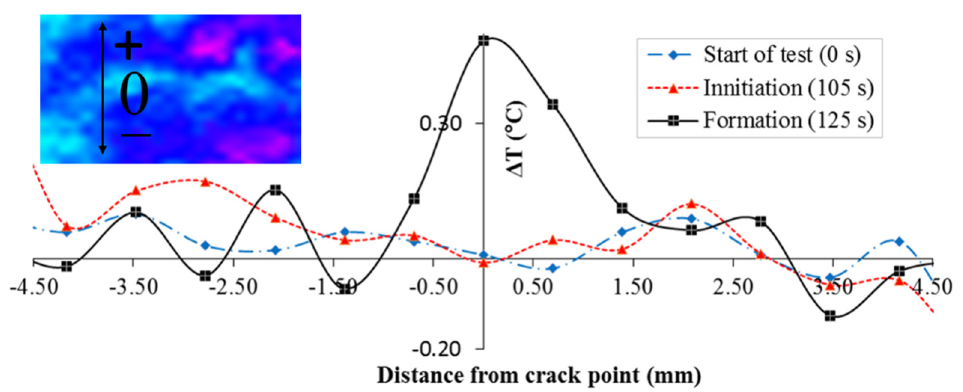
Figure 8. Temperature profile along a measurement line approximately perpendicular to the crack (the position of the measurement line is marked on the temperature profile attached on the top left).